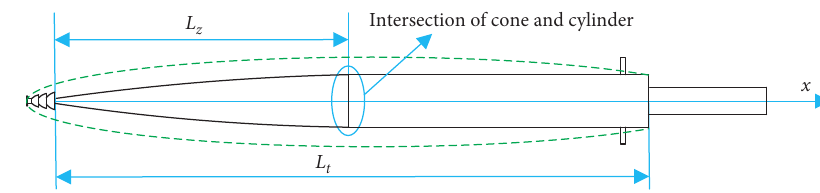
Figure 6: The expected shape of the